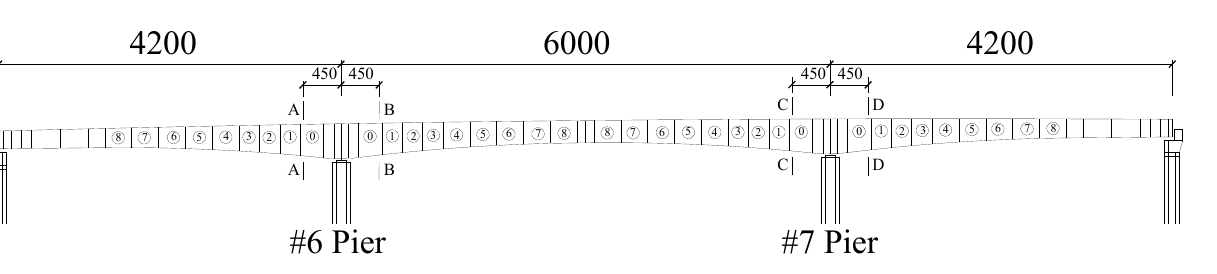
Figure 1. Elevation sketch of Huangsha Harbor Bridge (unit: cm).